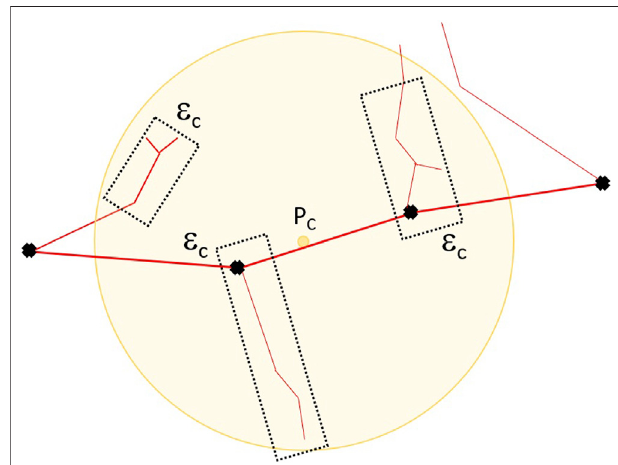
FIGURE 4 | Schematic representation of the scoring method for the evaluationoftheenergydepositedpersingleprotoncollisioninthesite, ε c .The primary δ -ray generated by the proton collision is identi fi ed and assigned one distinctive tag, that is then inherited by all the secondary electrons in the shower. Only the energy deposition events happening within the site are accounted for in the calculation of ε c , including δ -ray in fl ux from outside the site.